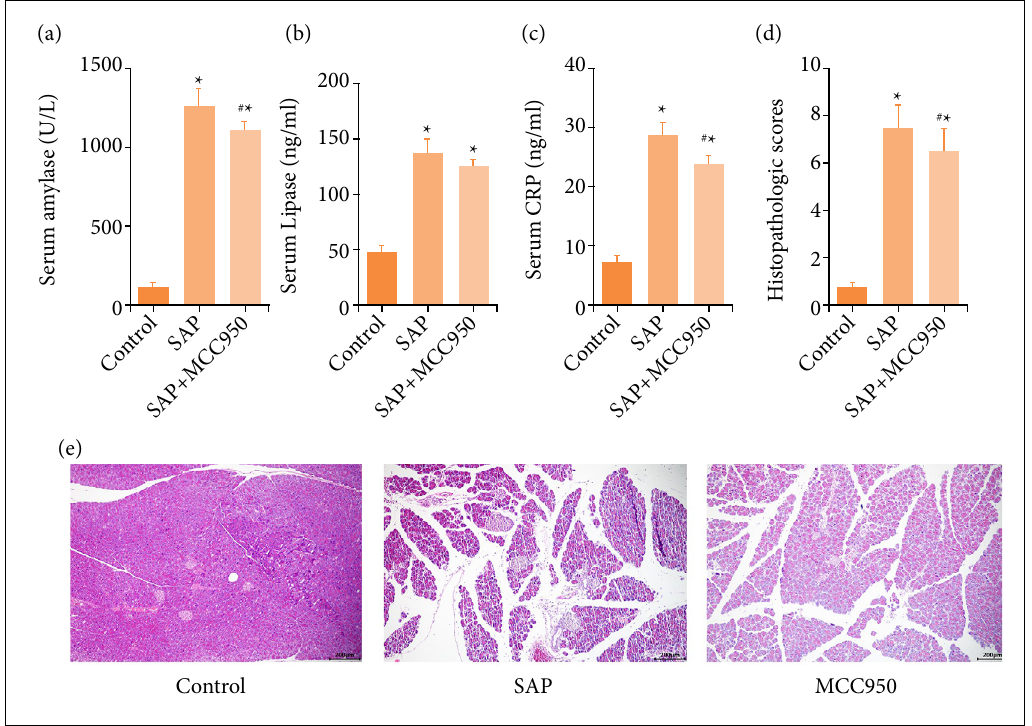
Figure 3 - Protective effect of MCC950 on pancreatic injury; (a) Amylase; (b) Lipase; (c) CRP; (d) Pancreas pathological score; (e) Pancreatic HE staining. N = 6, * p < 0.01 vs. control; # p < 0.05 vs.